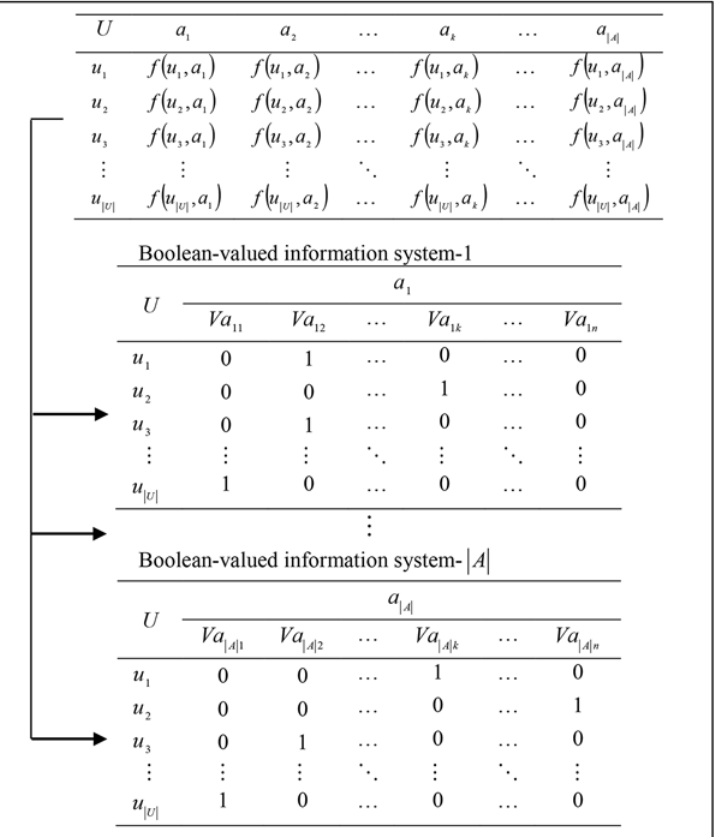
Fig 1. A decomposition of information